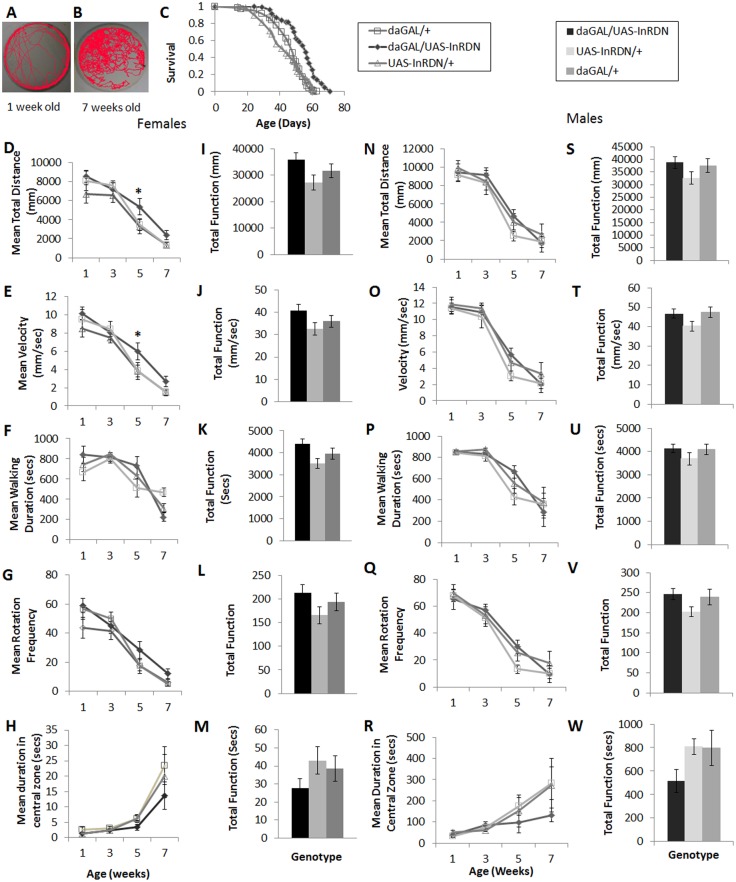
Exploratory walking senescence in daGAL4/UAS-InRDN male and female flies.(A-B) Representative images of the exploratory walking track of an individual wDah control female fly at 1 week old (A) and 7 weeks old (B) during a 15 minute observation period. (C) Survival of daGAL4/UAS-InRDN once mated female flies compared to daGAL4/+ and UAS-InRDN/+ controls. Median lifespans and sample sizes were: daGAL4/UAS-InRDN = 56 days, N = 69; daGAL4/+ = 48 days, N = 99; and UAS-InRDN/+ = 44 days, N = 60. Survival curves were compared using nonparametric log rank tests and p values calculated. daGAL4/UAS-InRDN showed an increased survival compared to both controls (P<0.0001). (D-M) Exploratory walking senescence for a cohort of female flies of the indicated genotypes run in parallel with the survival experiment shown in (C). Data are shown as mean value for each parameter ±SEM, N = 12 for the indicated genotype. (D) Female mean distance walked (mm) vs age. (I) Female Total Function of mean distance walked (mm). (E) Female Mean velocity (mm/sec) vs age. (J) Female Total Function of mean velocity (mm/sec). (F) Female Mean walking duration (secs) vs age. (K) Female Total Function of mean walking duration (secs). (G) Female Mean frequency of rotations (change in walking direction) vs age. (L) Female Total Function of mean Rotation Frequency. (H) Female Mean Duration in Central Zone (secs) vs age. (M) Female Total Function of mean duration in central Zone (secs). (N-W) Exploratory walking senescence for a cohort of male flies of the indicated genotypes run in parallel with the survival experiment shown in Fig 1G. Data are shown as mean value for each parameter ±SEM, N = 12 for the indicated genotype. (N) Male mean distance walked (mm) vs age. (T) Male Total Function of mean distance walked (mm). (O) Male Mean velocity (mm/sec) vs age. (T) Male Total Function of mean velocity (mm/sec). (P) Mean walking duration (secs) vs age. (U) Male Total Function of mean walking duration (secs). (Q) Mean frequency of rotations (change in walking direction) vs age. (V) Male Total Function of mean Rotation Frequency. (R) Male Mean Duration in Central Zone (secs) vs age. (W) Total Function of mean duration in central Zone (secs). Data were analysed by two way ANOVA and genotype and age found to be the main effects (p<0.05). Data at individual time points or total function data were analysed by one way ANOVA followed by post hoc means comparisons using Tukey HSD, and * indicates significant differences (p<0.05) between daGAL4/UAS-InRDN flies and both controls.